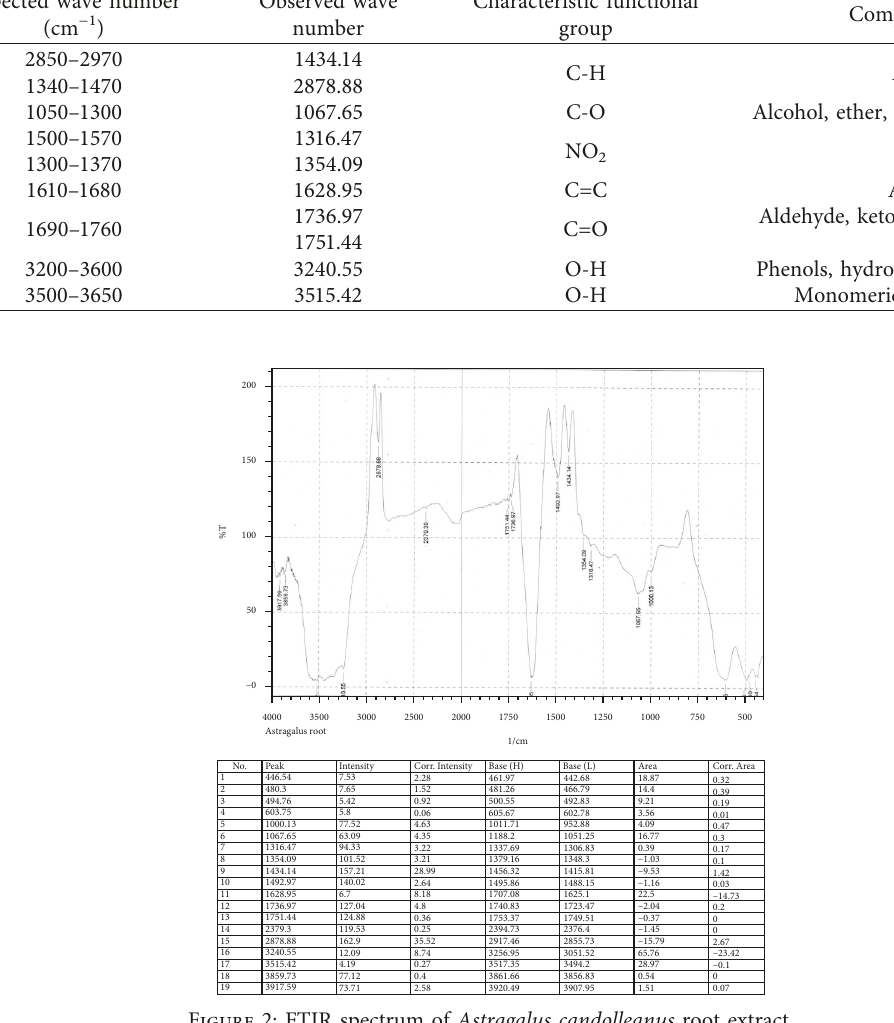
Figure 2: FTIR spectrum of Astragalus candolleanus root